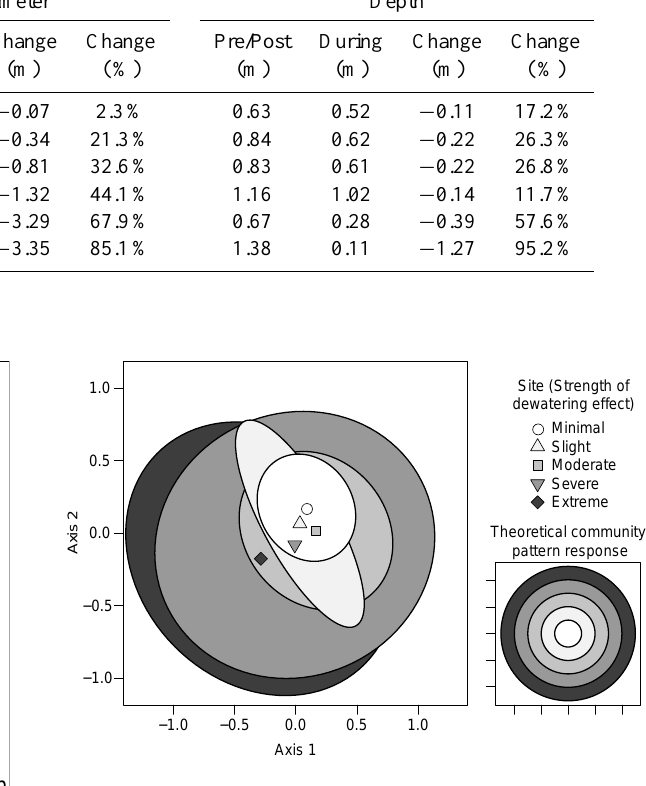
Fig. 3. The macroinvertebrate community NMS ordination, with groupings according to sample site (main panel). The smaller panel is a theoretical ordination of the communities showing increasing dispersion with dewatering severity extending outward in concen- tric circles. Ellipses are 95% confidence